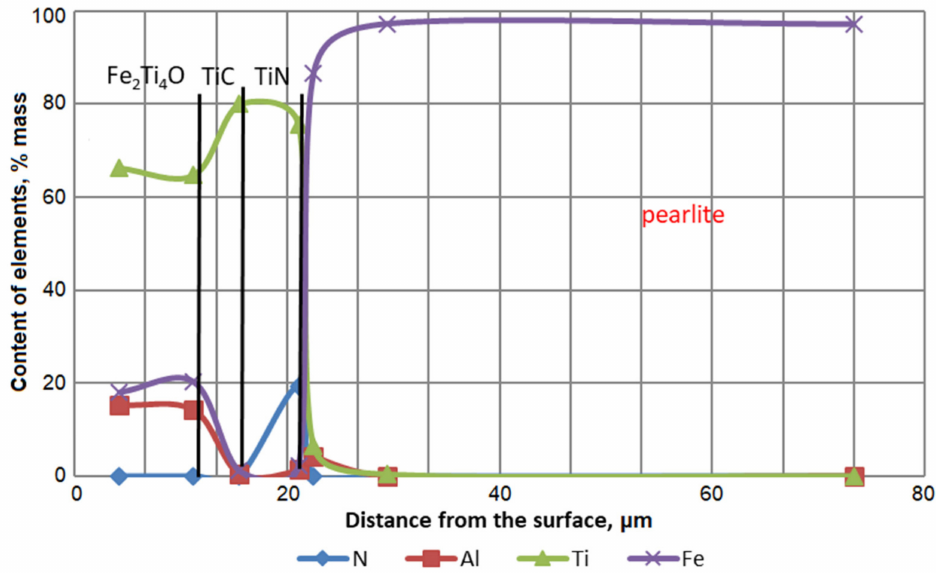
Figure 4. Distribution of elements in titanium aluminized coatings on AISI W1-7 nitrous steel; nitriding (540 ◦ C, 36 h); titanium aluminizing (1050 ◦ C, 4